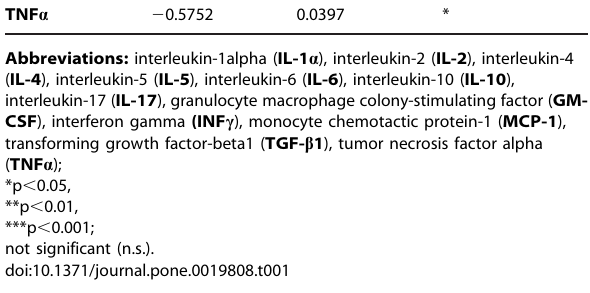
Abbreviations: interleukin-1alpha ( IL-1 a ), interleukin-2 ( IL-2 ), interleukin-4 ( IL-4 ), interleukin-5 ( IL-5 ), interleukin-6 ( IL-6 ), interleukin-10 ( IL-10 ), interleukin-17 ( IL-17 ), granulocyte macrophage colony-stimulating factor ( GM- CSF ), interferon gamma (INF c ), monocyte chemotactic protein-1 ( MCP-1